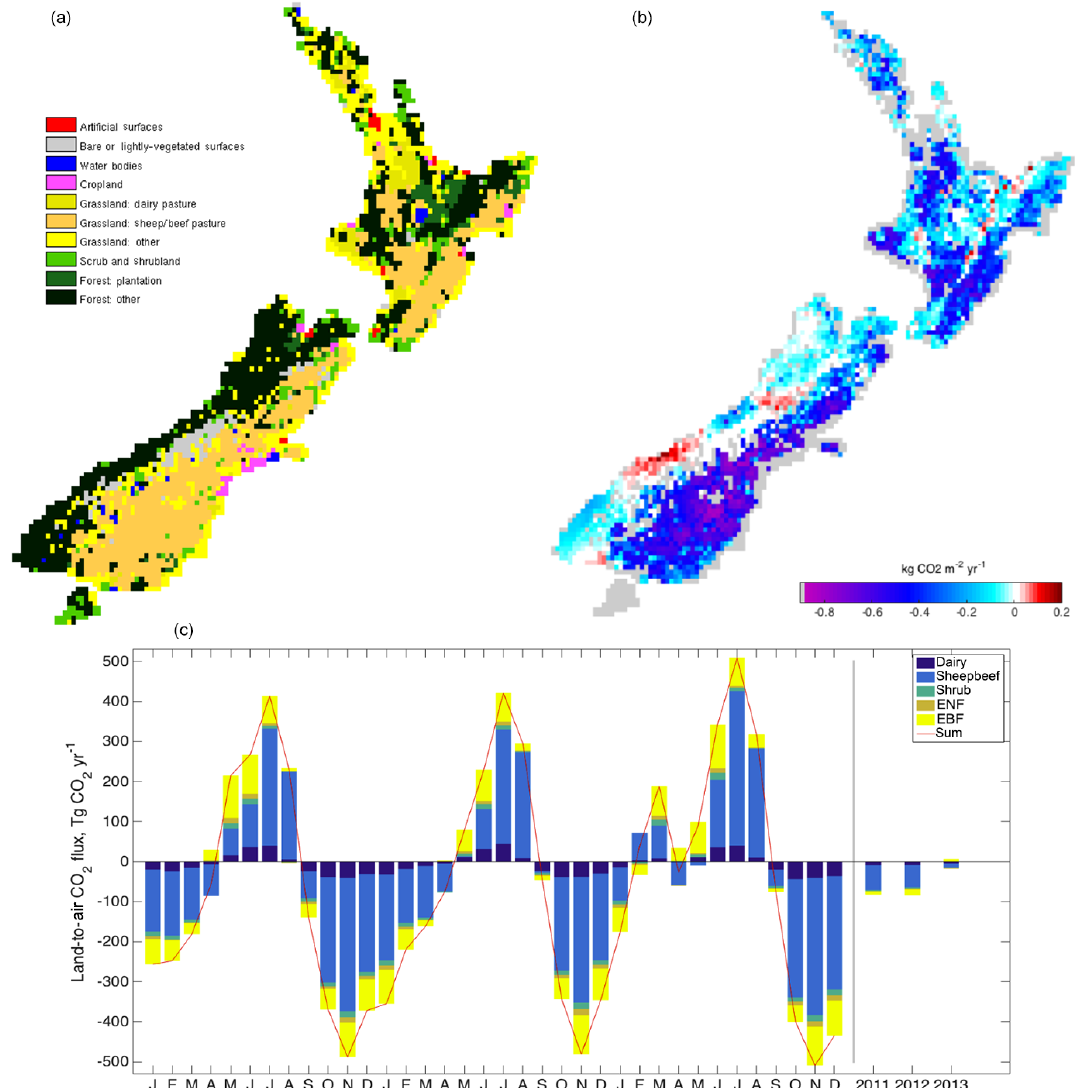
Figure 5. (a) Land-cover and land-use (LCLU) map with 10 categories, based on the Land Cover Database (LCDB3) and the Land Use in Rural New Zealand (LURNZ) basemap. (b) A priori CO 2 flux distribution, averaged over 2011–2013, from modelled NEP using Biome- BGC with the LCLU categories. Both maps have been regridded to the NAME model grid. (c) Monthly and annual contributions from each biome to the overall a priori CO 2